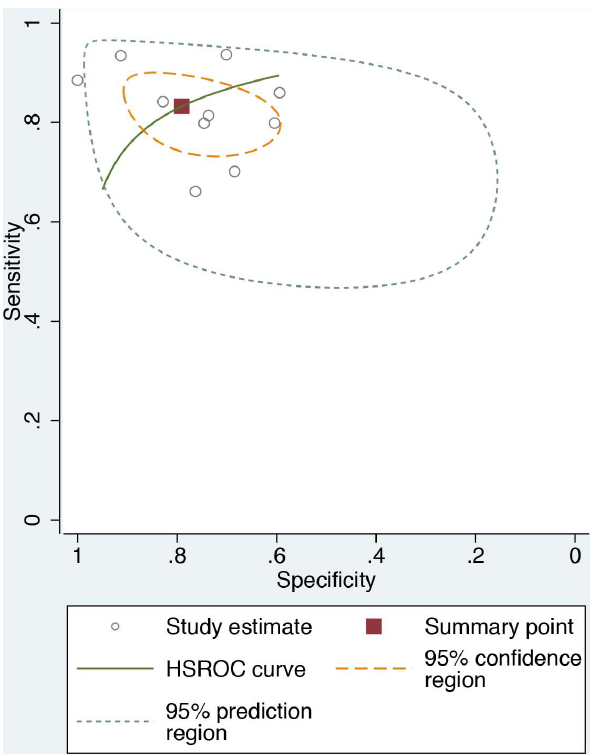
Figure 3. Hierarchical Summary Receiver Operating Characteristic (HSROC)